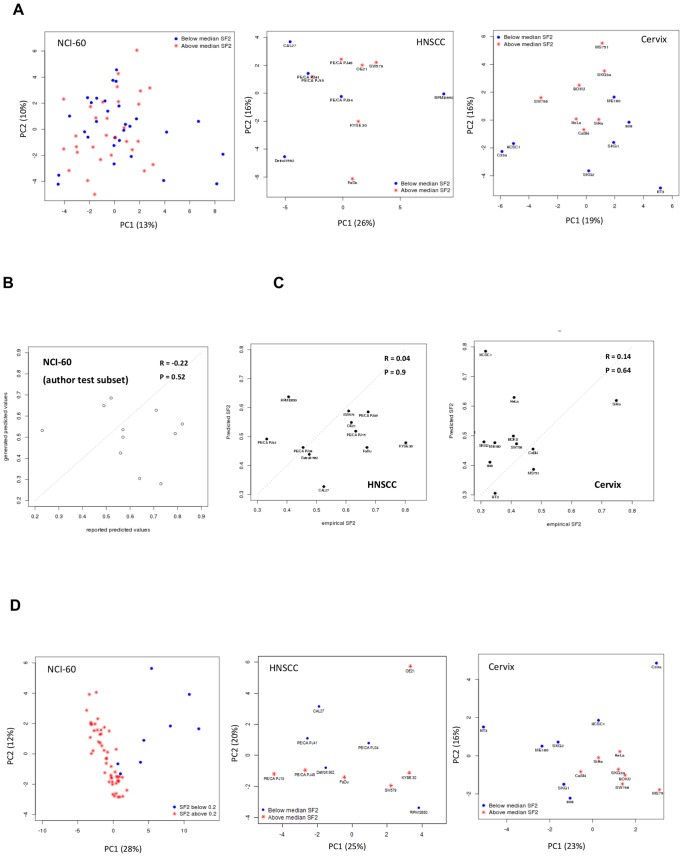
Assessment of established radiosensitivity gene signatures.
A) PCA of the Tewari radiosensitivity gene signature. The original signature consists of 49 genes, with mapping to the NCI-60 (60 Plus2 probesets) HNSCC (60 Plus2 probesets) and cervix cell line (48/49 genes) datasets. The x-axis shows PC1, accounting for the largest amount of variation in the experiment and the y-axis shows the second principal component (PC2). Colouring based on median SF2, blue data-points are radiosensitive cell lines (below the median SF2) with red data-points being the radioresistant lines (above the median SF2). B) Implementation of the Eschrich radiosensitivity model [12]. Applied to a training set of 16 samples from the NCI-60 [13]. xy-scatterplot with the x-axis showing reported SF2 values, generated with these cell lines on a earlier array type (U95) against values generated by implementing the model in the current U133 plus 2.0 dataset (y-axis). Line indicates perfect correlation. C) Applied to the HNSCC and cervix cancer cell line cohorts. The y-axis indicates the predicted SF2 determined from the radiosensitivity model. The x-axis shows the empirically derived SF2 values. D) Principal component analysis of the Amundson radiosensitivity gene signature [10]. The original signature consists of 22 genes (33 Plus2 probesets), with mapping to the NCI-60 (33 Plus2 probesets), HNSCC (33 Plus2 probesets) and cervix cell line (21/22 genes) datasets. The x-axis shows PC1, accounting for the largest amount of variation in the experiment and the y-axis shows the second principal component (PC2). In the NCI-60 data colouring is based a threshold of 0.2 (previously defined [21] where the HNSCC and cervix cell line datasets are coloured by median SF2. In all cases blue data-points are radiosensitive cell lines (below the median SF2) with red data-points being the radioresistant lines (above the median SF2).